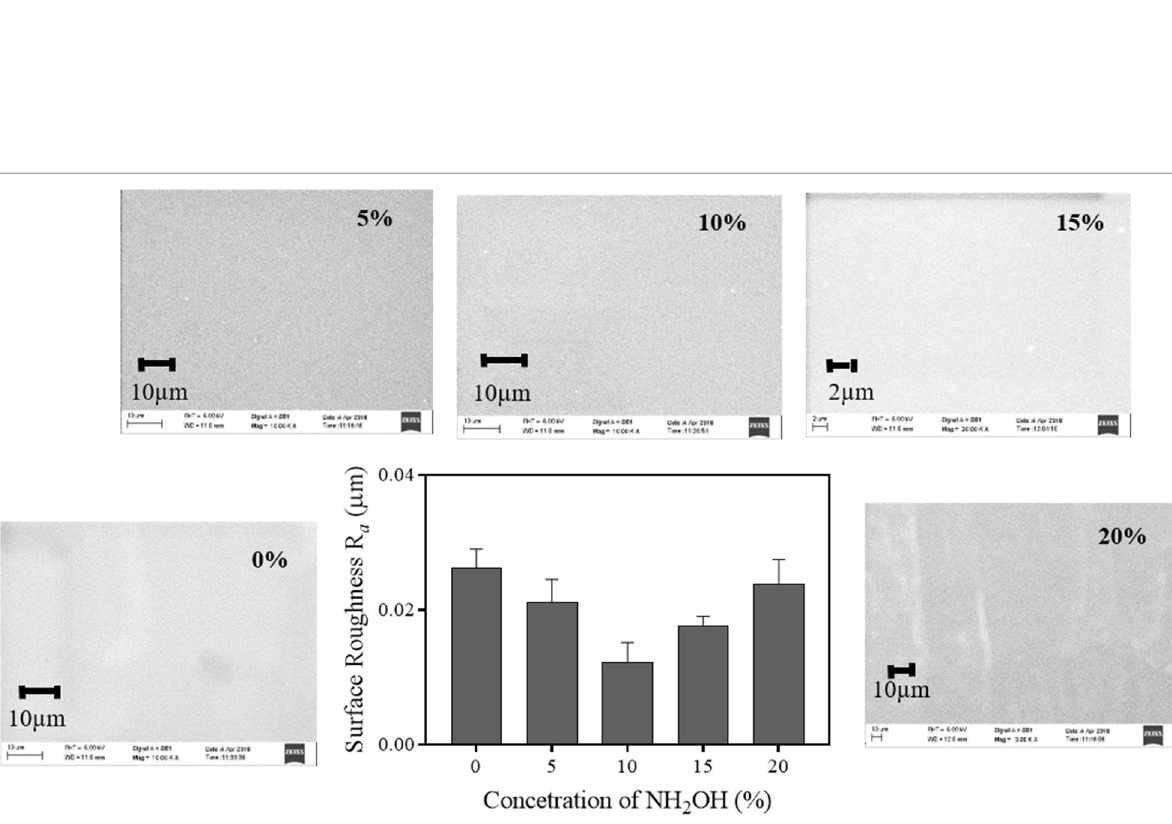
Fig. 41 Etched surface roughness (Ra) and corresponding surface morphologies of Si{111} in pure and different concentrations of NH 2 OH added 5% TMAH at 70 1 °C ±